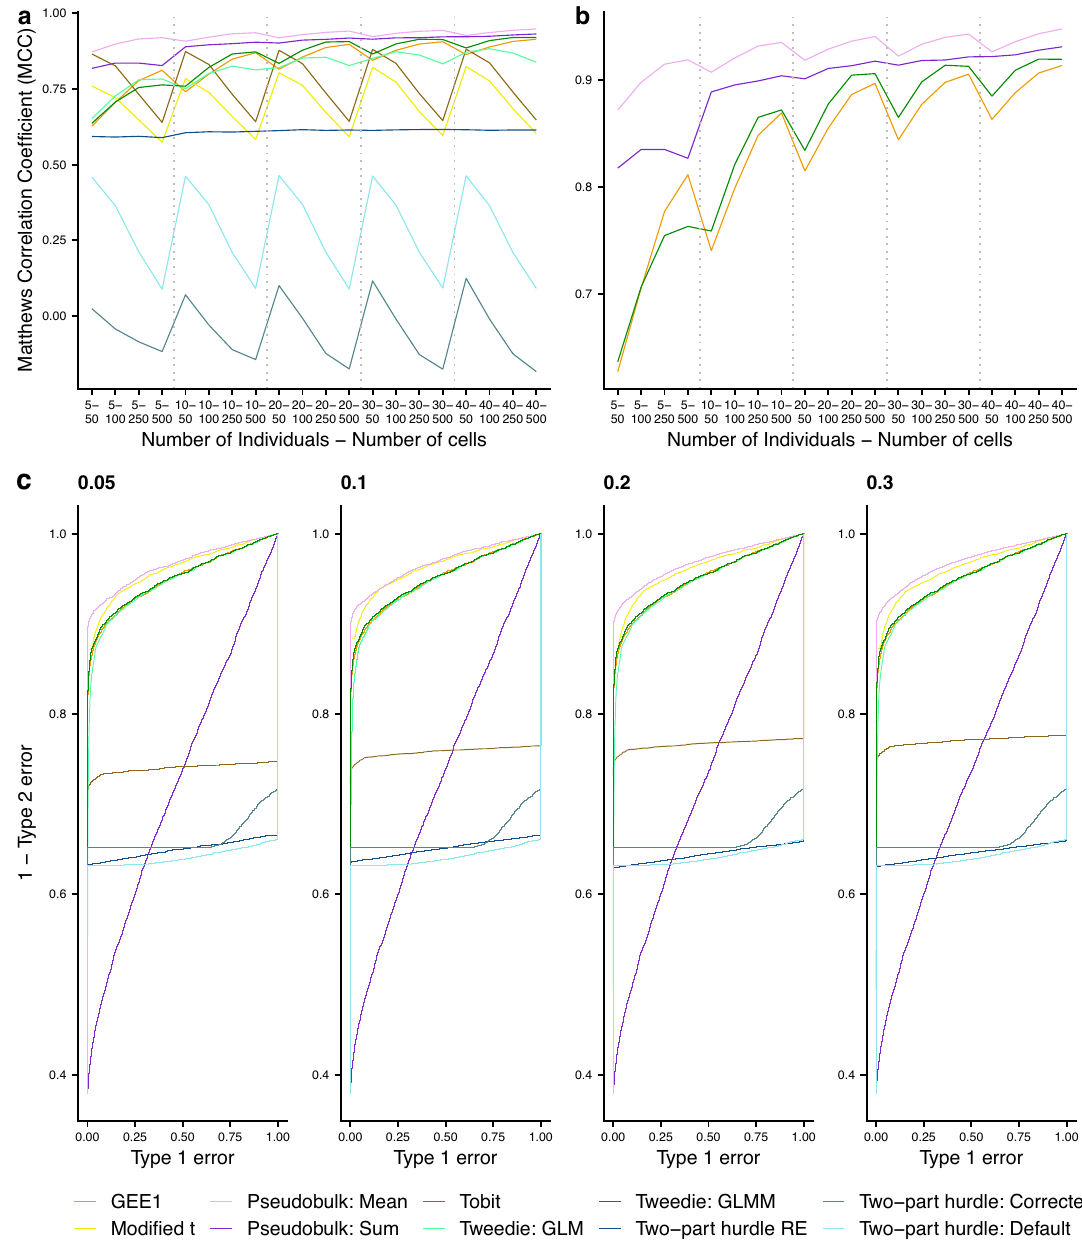
Fig. 1 | Performance of the analysed models. a , b give the average Matthews correlation coef fi cient from the 20,000 iterations; 50 runs for each of the 5 – 40 individuals and 50 – 500 cells at a p -value cut-off of 0.05 on 10,000 genes. a shows allbenchmarkedmodelswhereas b focusesonthetopfourapproaches. c givesthe receiver operating characteristics (ROC) curve across 50 runs each for different proportions of simulated differentially expressed genes (DEGs) — 0.05, 0.1, 0.2, 0.3. Twenty individuals were simulated for case and controls, each with 100 cells. The